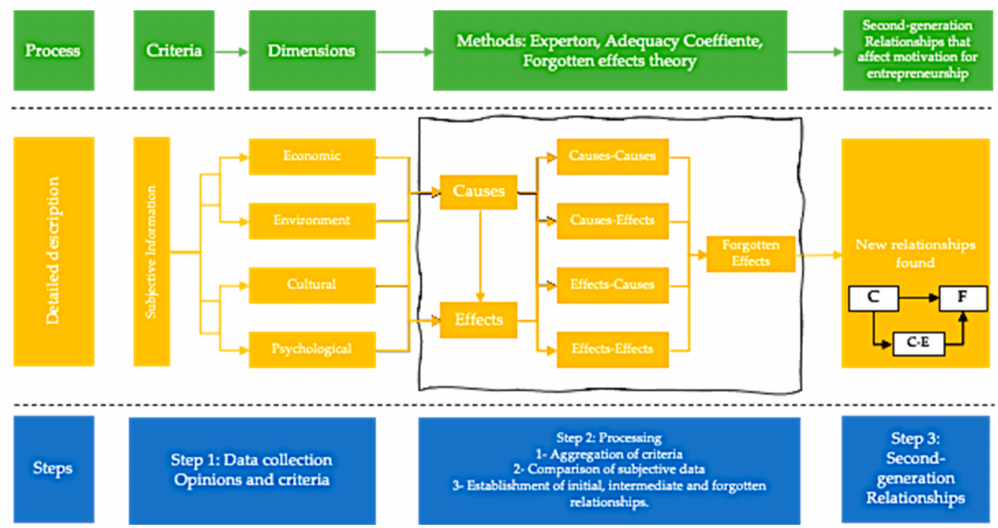
Figure 1. A second-generation relationship model for entrepreneurship motivation. Source: Authors’ elaboration based on the studies of Kaufmann and Gil-Aluja